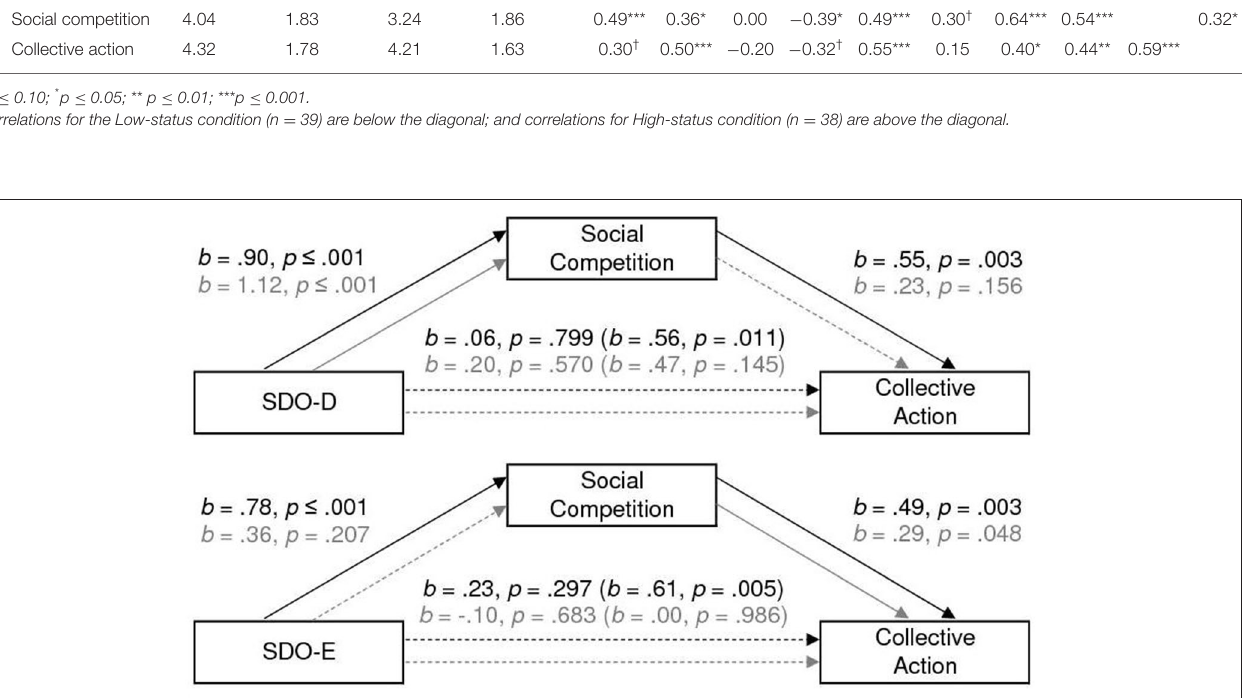
independent mediation models: two independent models for each SDO subdimensions, for each status condition (two for the low-status condition and two for the high-status condition). All reported coefficients are